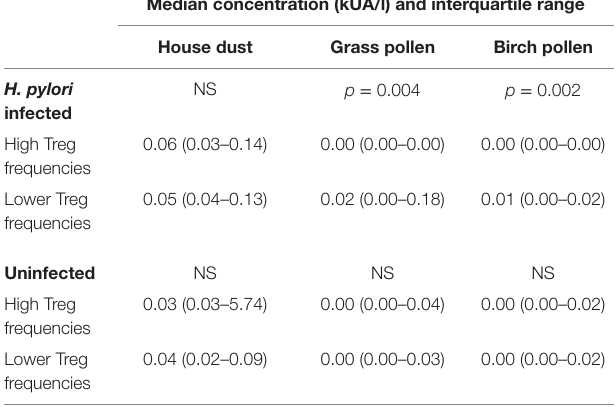
TaBle 3 | allergen-specific ige levels in the plasma of 49 infected and 46 uninfected patients with high and lower peripheral blood cD4 + cD25 hi cell